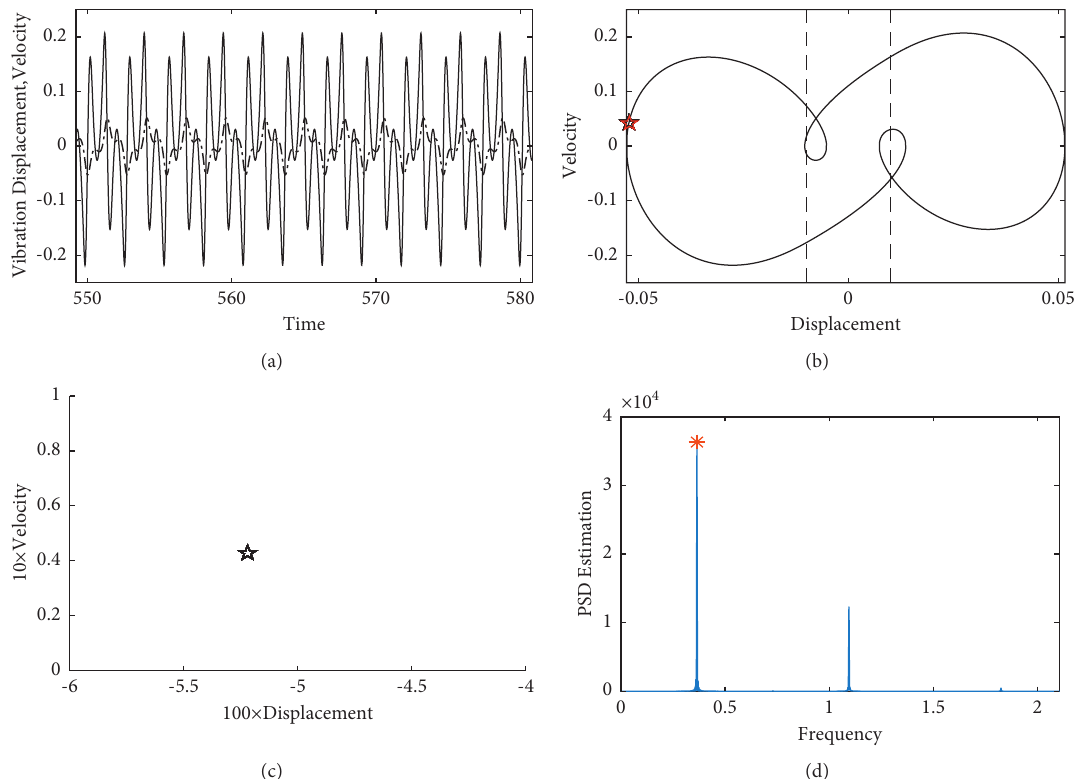
Figure 10: f � 0 . 365 Hz ， asymmetric period 1-1-2. (a) Time history graph. (b) Phase diagram. (c) Poincar ´ e section. (d) Power spectral density